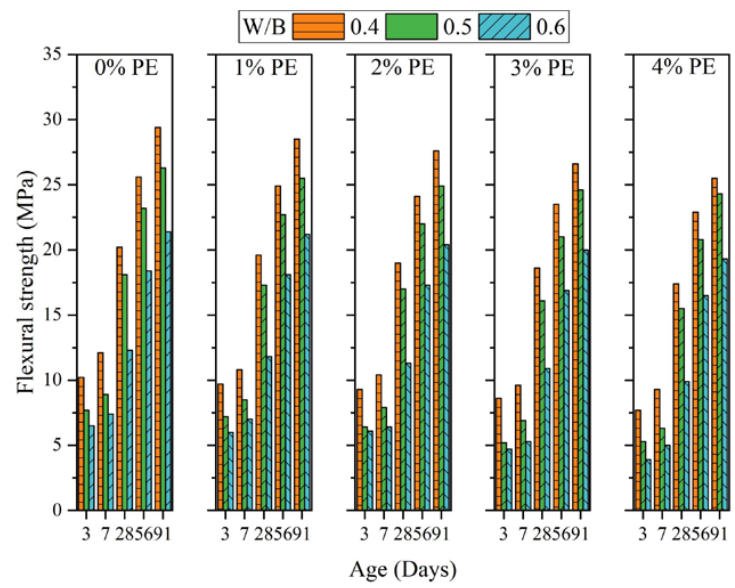
Figure 6. Flexural strength of cement mortar with different W/B ratios and waste PE.